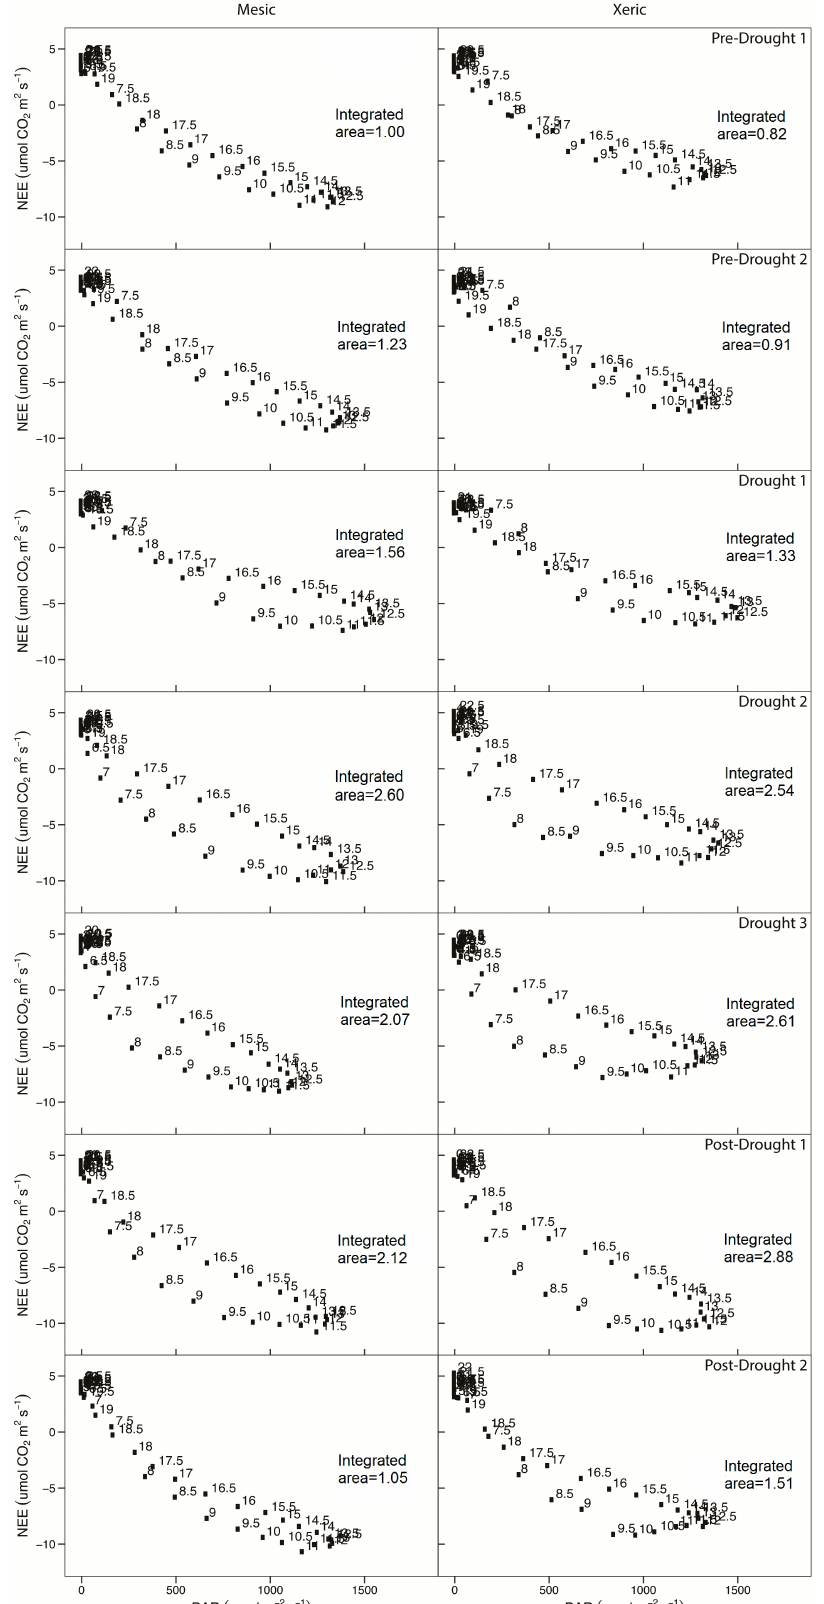
Figure 6. Annual diurnal patterns of net ecosystem exchange of CO 2 (NEE) averaged at each half-hour in each site during each year of the study, from early morning to afternoon. Integrated area represents daytime physiological activity, relative to mesic site pre-drought year